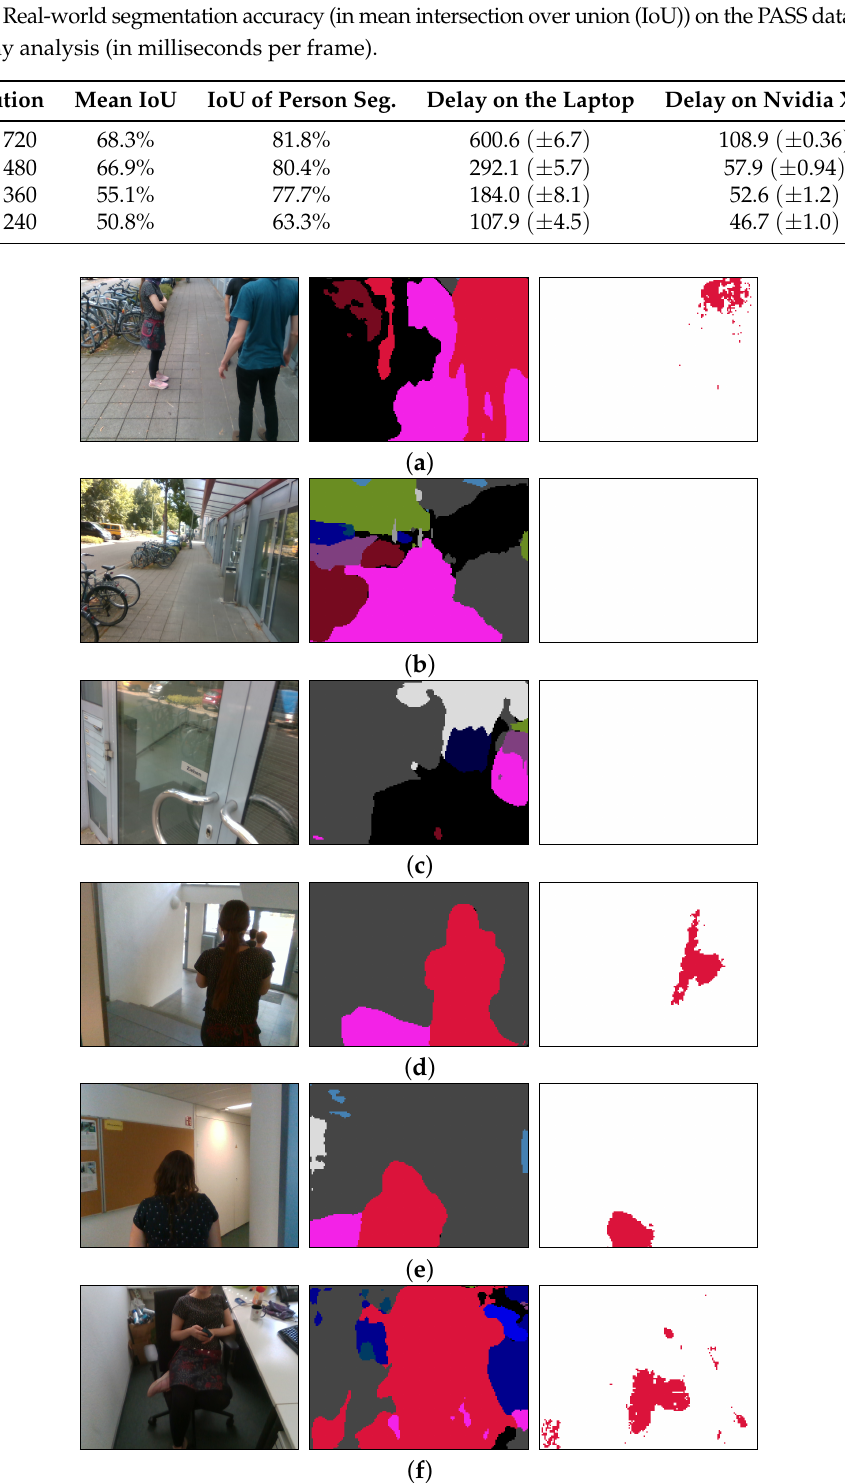
Figure 8. The color image ( left ), the segmentation mask ( middle ) and the sonified pixels ( right ). Persons are labeled in red. Our system works outdoors ( a – c ) and indoors ( d – f ). Sonification only occurs when persons are present in the image. ( a ) A group is talking in front of a door; ( b ) the same scenario without people, which produces no sonification; ( c ) despite being close to a door, there is no sonification; ( d ) following a person; ( e ) following a person; ( f ) talking to a